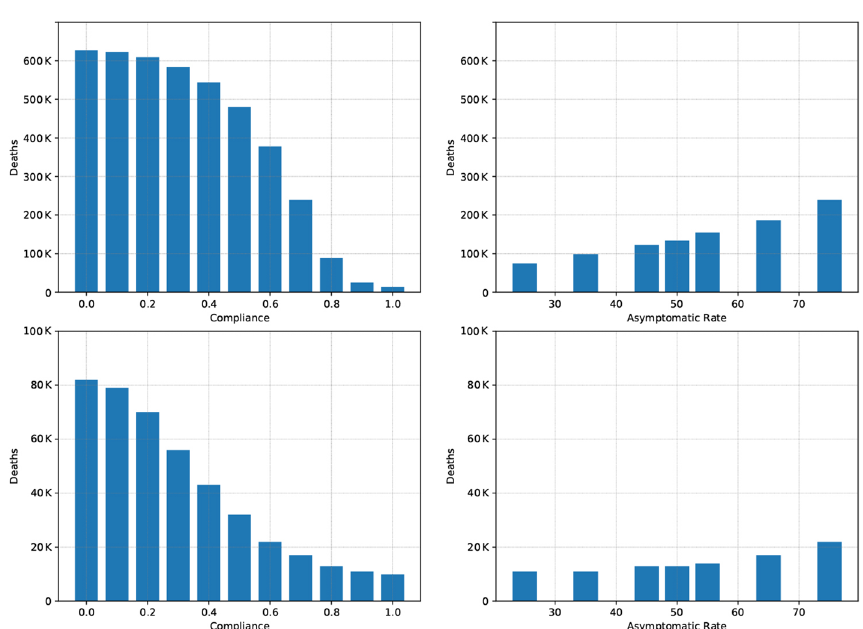
Figure 4. Role of compliance and the asymptomatic rate for tracing. Panel (top-left): Changing Compliance in B2. Panel (top-right): Changing the Asymptomatic Rate in B2 with high ( 80% ) compliance. (bottom-left): Changing Compliance in GSD3. Panel (bottom-right): Changing the Asymptomatic Rate in GSD3 with high ( 80% )